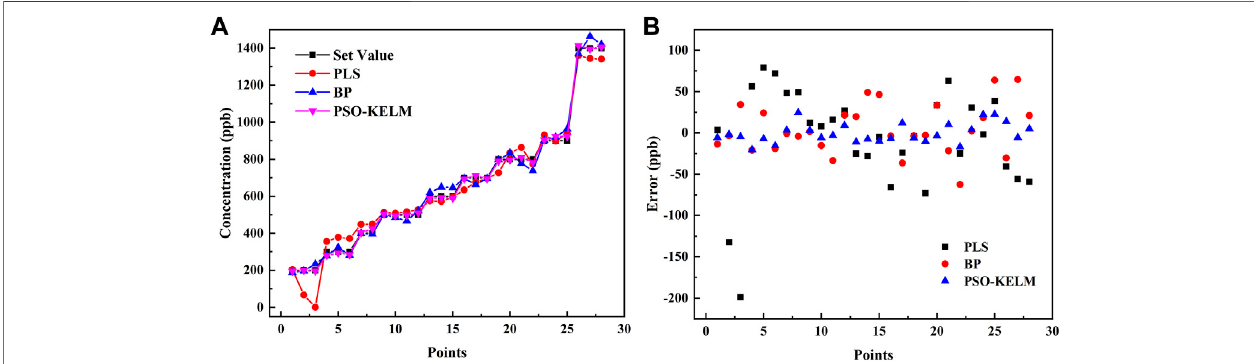
FIGURE 6 | (A) Comparison of the set values and predicted results of the BP neural network, PLS and PSO-KELM algorithms. (B) Error comparison of the set values and predicted results of the BP neural network, PLS and PSO-KELM algorithms.